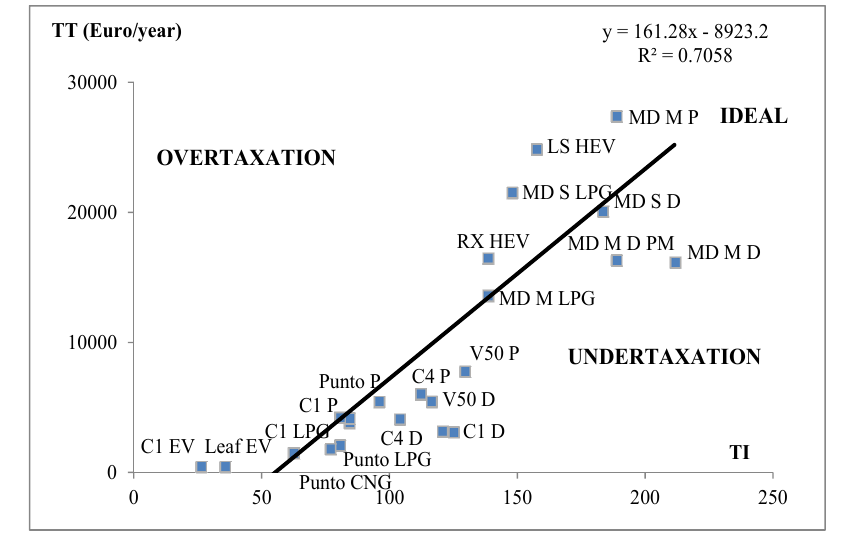
-differentiated 2